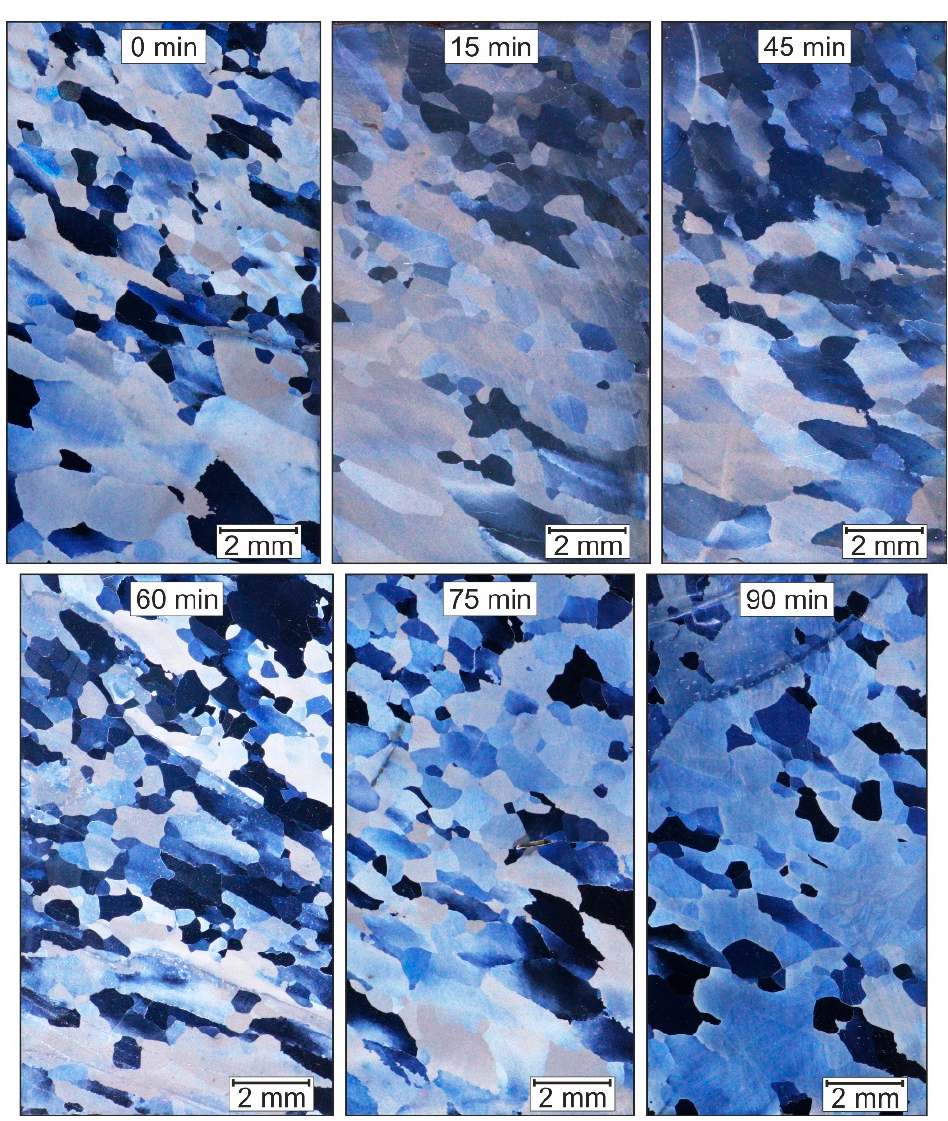
Figure 4. Fe28Al after one ECAP Pass and being heat-treated at 750 °C with different recovery times. Table 2. Comparison between Fe28Al formed through ECAP plus being heat-treated at 750 °C for different holding times, and the results of cast/bulk-formed Fe28Al at 1100 °C with 1 h of heat treatment (ht) [16]. Holding Time of ht in min.